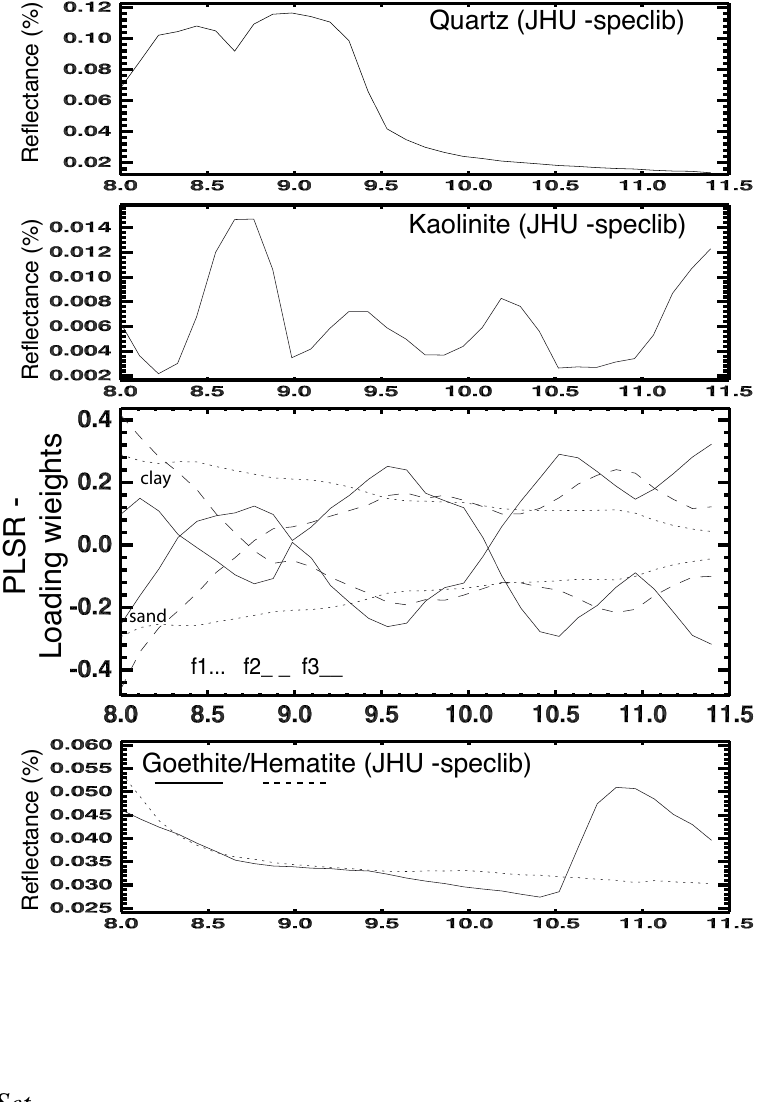
Figure 10. PLSR loading weights (factors 1–3) for the prediction of clay and sand in the TIR spectral region, and spectra of the relevant minerals from the ASTER spectral library [31], resampled to TASI-600 spectral